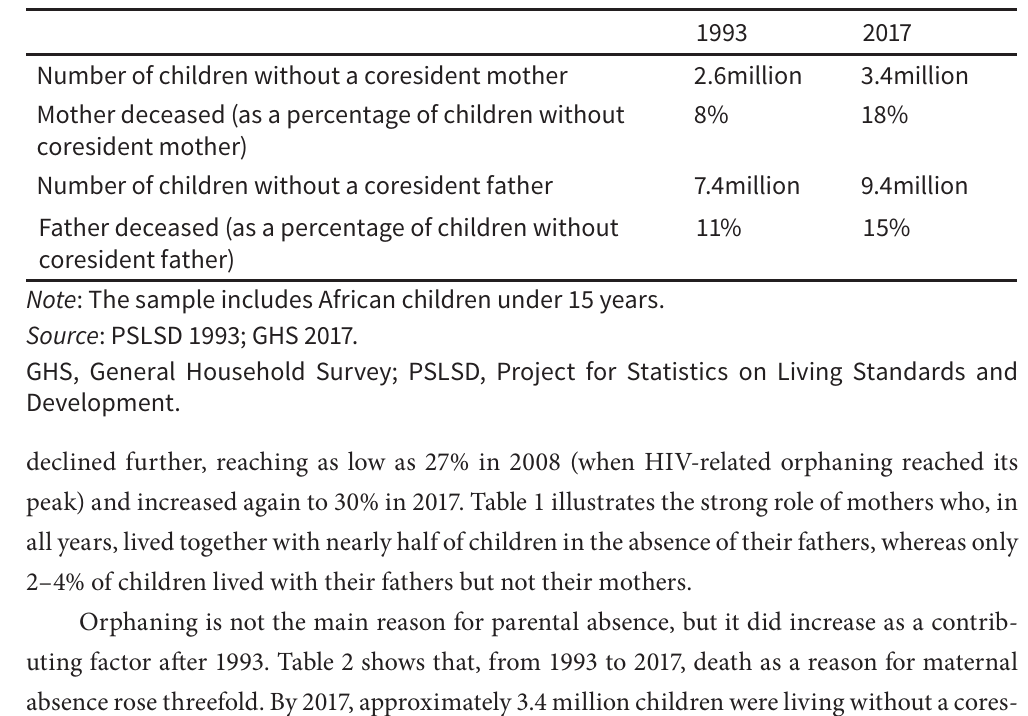
Contribution of orphaning to parental absence Number of children without a coresident mother Mother deceased (as a percentage of children